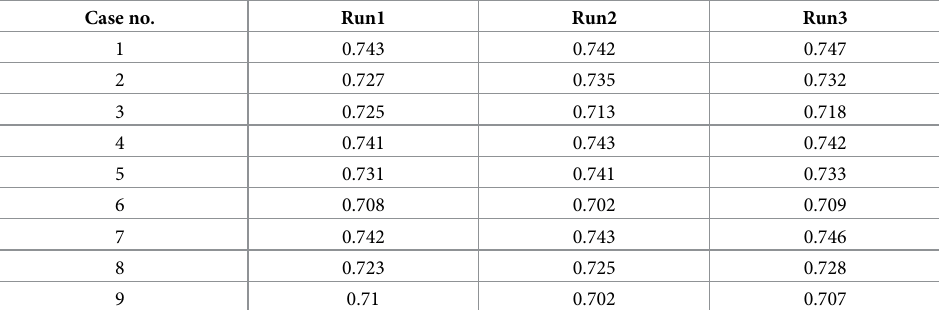
Table 6. Minimum RT values measured from the 27 runs.